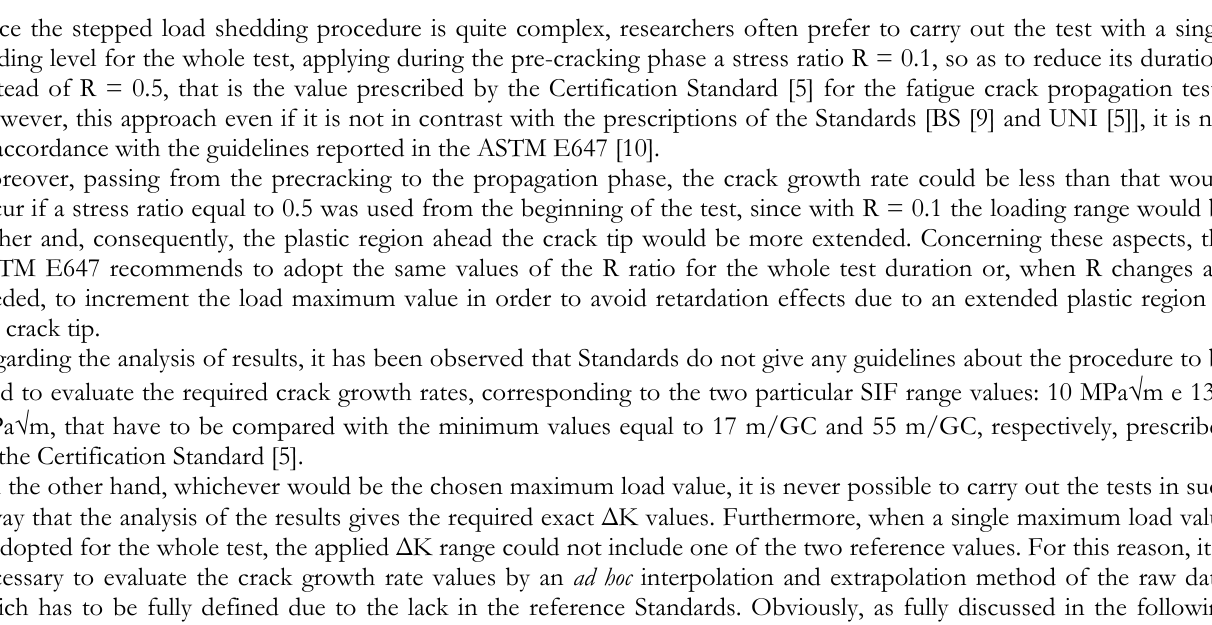
Figure 5: Precracking load spectrum of the FCG